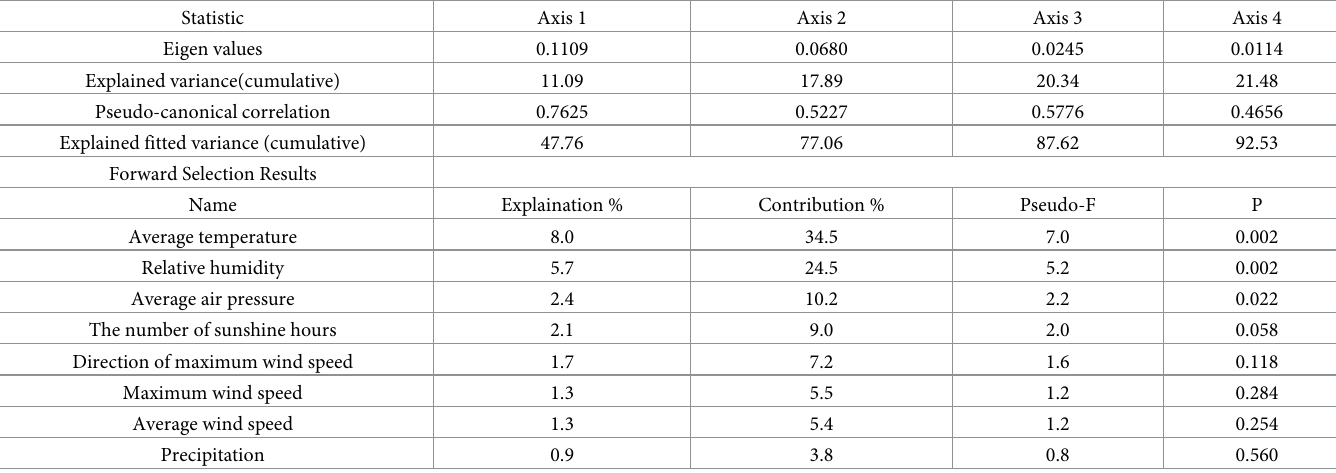
Table 1. Results of RDA of 15 pollen taxa and 8 meteorological parameters in central Zhanjiang city during 2015~2016.